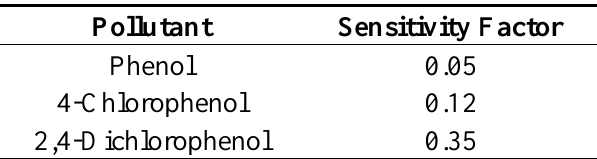
Table 1. Sensitivity